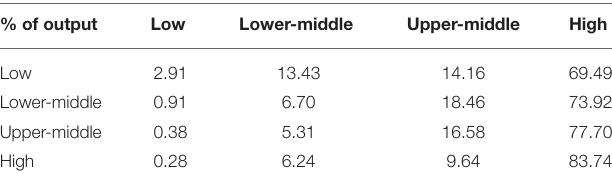
TABLE 2 | Proportion of collaborative output between 2010 and 2020 for global outputs by World Bank country classification